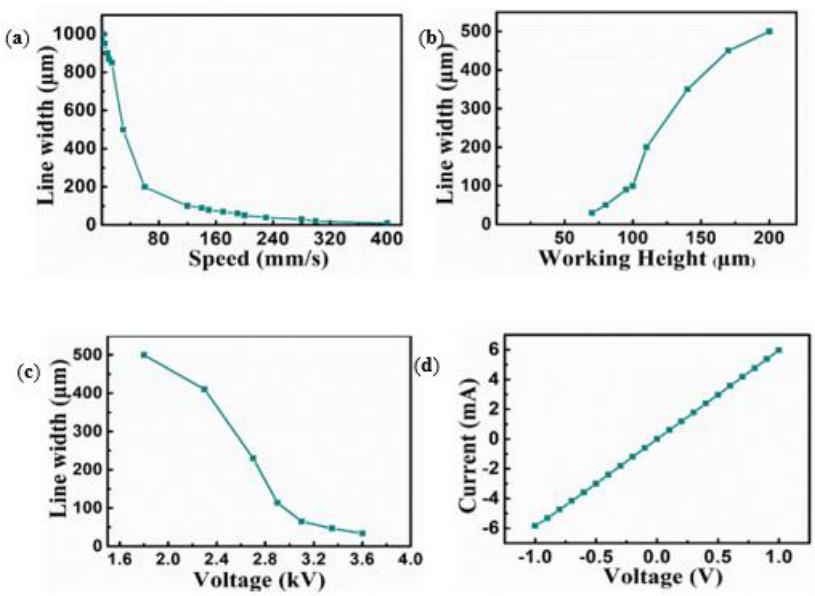
Figure 4. Parametric study of viscoelastic PDMS/xylene elastomer ink. ( a ) Effect of speed on the line width, ( b ) effect of nozzle height on the line width, ( c ) effect of voltage on the line width, and ( d ) I–V curve.